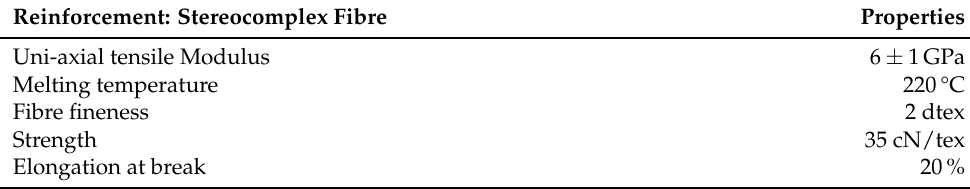
Table 2. Material properties of the stereocomplex fibres.